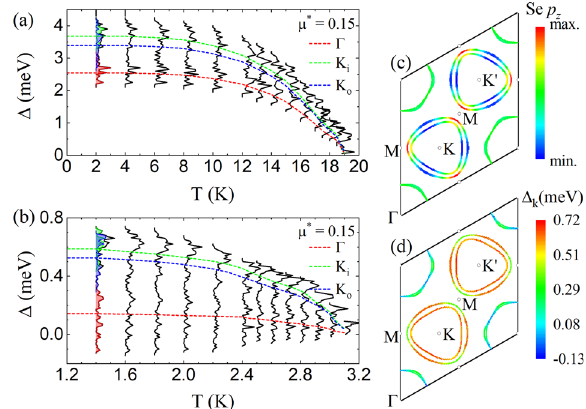
Fig. 2 Superconducting gap without and with spin- fl uctuation interaction. Energy distribution of the superconducting gap as a function of temperature computed over the full BZ by solving the anisotropic Eliashberg Eqs. (6) and (7) ( a ) without and ( b ) with the inclusion of spin fl uctuations. Each curve represents a histogram of gap values at a particular T shown on the x axis; the height of the histograms is related to the number of states on the FS with that superconducting gap energy. The colored shaded areas at lowest temperature indicate data belonging to different FS sheets: Γ (red), K i (green), and K o (blue). The dashed red, green, and blue curves are averages of the anisotropic solutions. c Cross section of the Fermi surface with Se p z character. d Momentum-resolved superconduct- ing gap Δ k on the Fermi surface corresponding to the anisotropic Eliashberg calculations with the inclusion of spin fl uctuations at T = 1.4